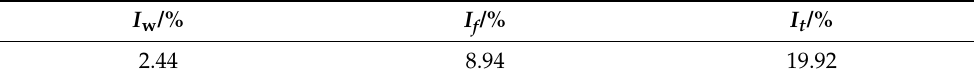
Table 5. Forming results of the thin-walled tube using an ordinary non-ball